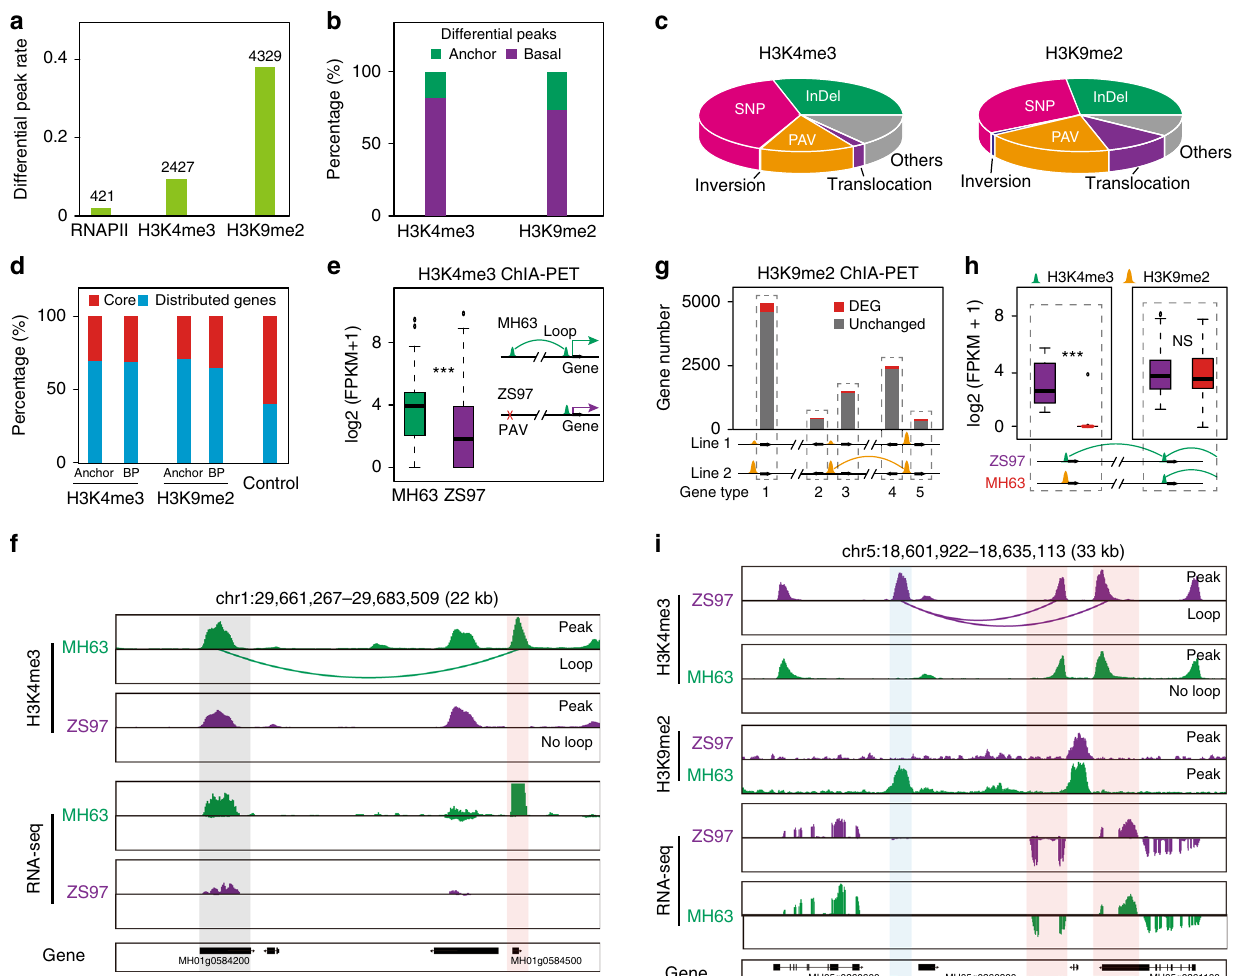
Fig. 5 Effects of genetic variations on chromatin topology and transcription. a Rates and numbers of H3K4me3 and H3K9me2binding sites and RNAPII occupancy in the two rice varieties MH63 and ZS97. b Percentages of H3K4me3 and H3K9me2 differential peaks involved and not involved in chromatin interactions. c Pie chart for the proportion of different genetic variation types overlapped with H3K4me3 (upper) and H3K9me2 (bottom) differential peaks involved in interactions. Most (~80%) differential peaks overlapped with single-nucleotide polymorphisms (SNPs), insertion/deletions (InDels), or presence/absence variations (PAVs). d Distributions of H3K4me3 and H3K9me2 differential peak-associated core and distributed genes. Percentages of core and distributed genes in 453 rice accessions serve as control. e Transcription level of loop-connected and not connected genes in MH63 and ZS97 caused by PAV (present in MH63 and absent in ZS97). *** p < 0.001 from Wilcoxon test. f Representative screenshot shows a H3K4me3 loop present in MH63 but absent in ZS97 caused by a PAV. The loop-connected gene MH01g0584200 in MH63 is more active than that in ZS97. g Expression change status of genes around (±10 kb) H3K9me2 differential peaks. From left to right, the bars represent (1) genes surrounding H3K9me2 differential peaks without interactions, (2) H3K9me2 differential peaks associated loop-outer genes, (3) H3K9me2 differential peaks associated loop-inner genes, (4) H3K9me2 differential peaks associated loop-connected loop-inner genes, (5) H3K9me2 differential peaks associated loop-connected loop-outer genes in turn. The red parts refer to the differentially expressed genes (DEGs), which occupy only a very small proportion (<10%). h Effect of H3K4me3 peaks and loops disrupted by H3K9me2 modi fi cation on transcription of genes on the indicated locus. Schematic below is a brief model. NS no signi fi cant difference. *** p < 0.001 from Wilcoxon test. i An example shows one H3K4me3 anchor was replaced by an H3K9me2 peak, causing the loop changes associated with the H3K4me3-marked region. However, there was no in fl uence on the expression of other looped genes. Boxplots in e , h show the median, and third and fi rst quartiles. Source data of f , i are provided as a source data fi